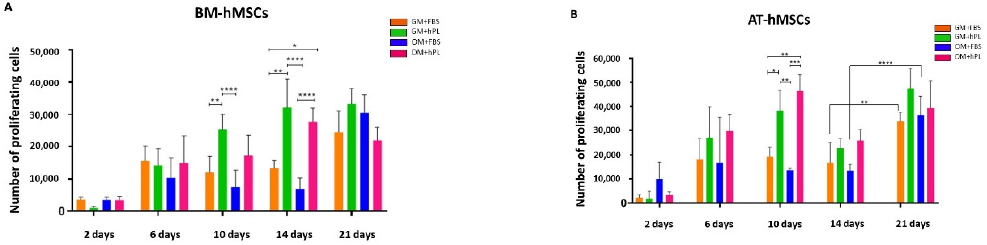
Figure 2. BM-hMSCs and AT-hMSCs proliferation in HC1 and HC2. ( A ) The figure reports the proliferation of BM-hMSCs cultured with GM+FBS or GM+hPL, in the presence of both HC1 and HC2, at different time points (2, 6, 10, 14 and 21 days). Data are expressed as the absolute number of proliferating cells in the sample. Statistical significances calculated by two-way ANOVA (* p ≤ 0.05, ** p ≤ 0.01, *** p ≤ 0.001, **** p ≤ 0.0001). ( B ) The figure reports the proliferation of AT-hMSCs cultured with GM+FBS or GM+hPL, in the presence of both HC1 and HC2, at different time points (2, 6, 10, 14 e 21 days). Data are expressed as the absolute number of proliferating cells in the sample. Statistical significances calculated by two-way ANOVA (* p ≤ 0.05, ** p ≤ 0.01, *** p ≤ 0.001, **** p ≤ 0.0001).